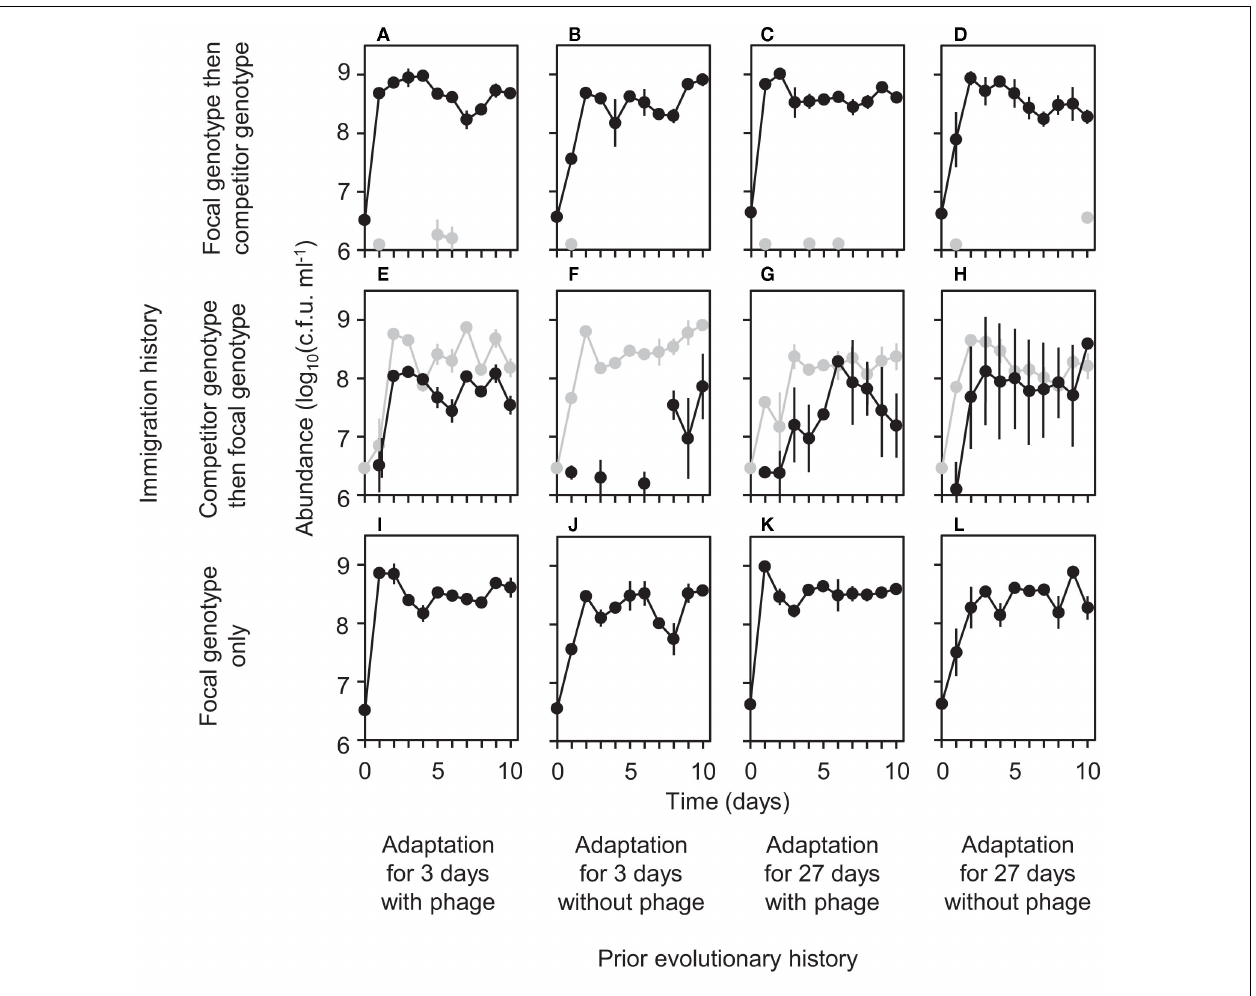
FIGURE 3 | Effects of prior evolutionary history and immigration history on bacterial abundance. Black lines indicate focal genotype and gray lines indicate competitor genotype. Each panel (A–L) shows mean abundance [log 10 (cfuml − 1 )] ± SEM ( n = 3) for the corresponding treatment of immigration history and prior evolutionary history.